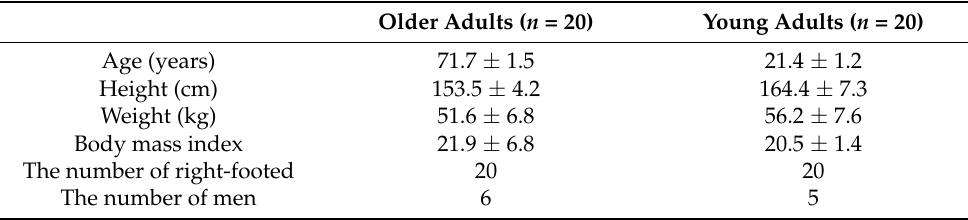
Table 1. Participant’s